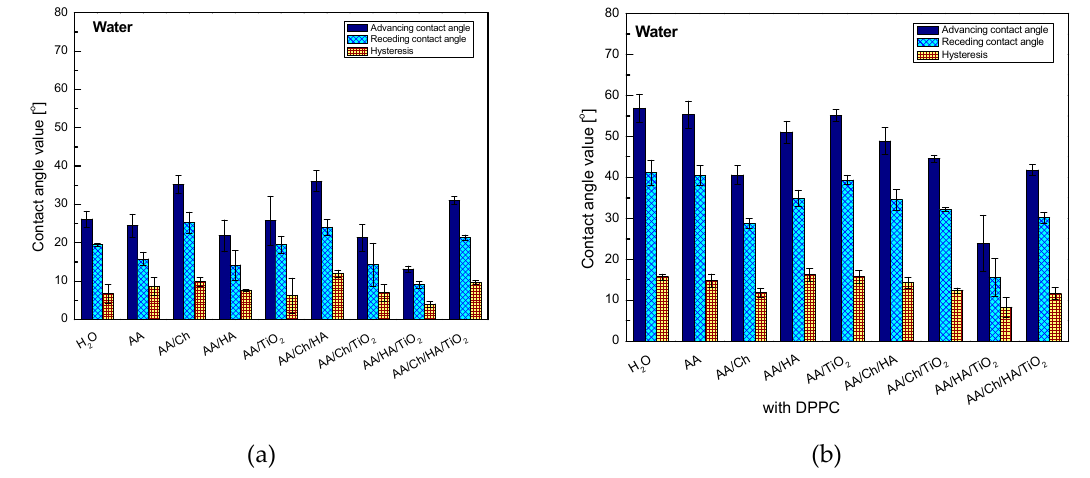
Figure 3. Advancing and receding contact angles of water (W) and its hysteresis on the activated glass plates after the contact with the subphase in the absence of DPPC ( a ) and in the presence of DPPC ( b ).